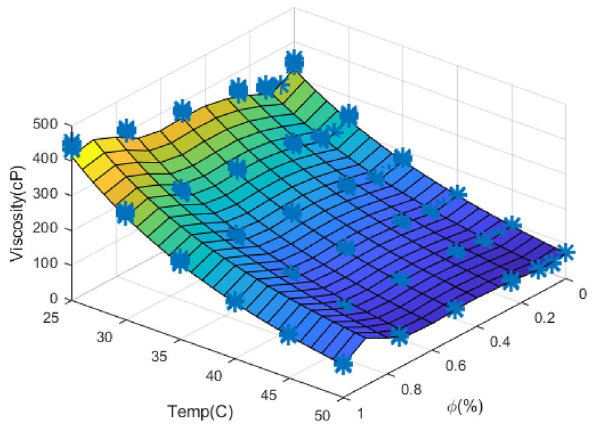
Figure 11. 3D graph of µ nf